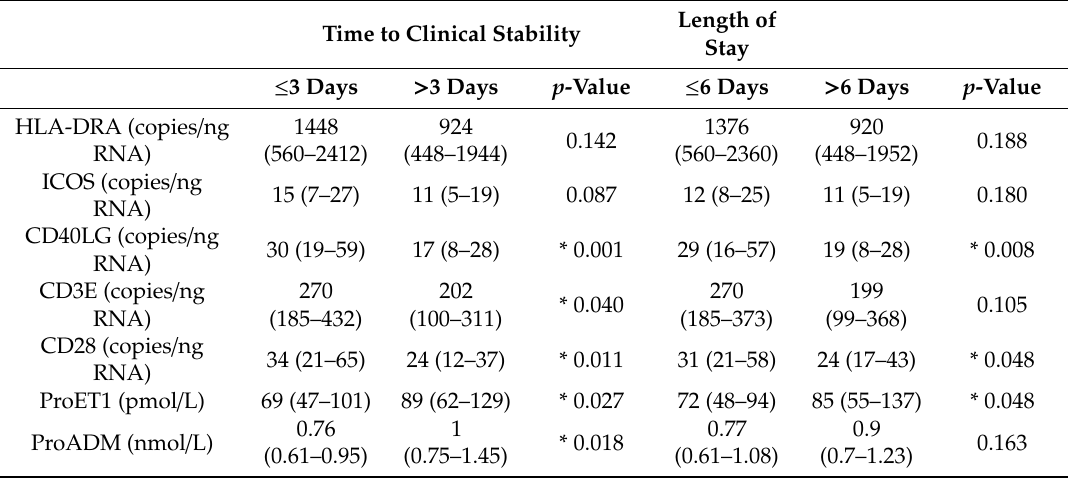
Table 3. Gene expression and biomarkers according to time to clinical stability and length of stay.